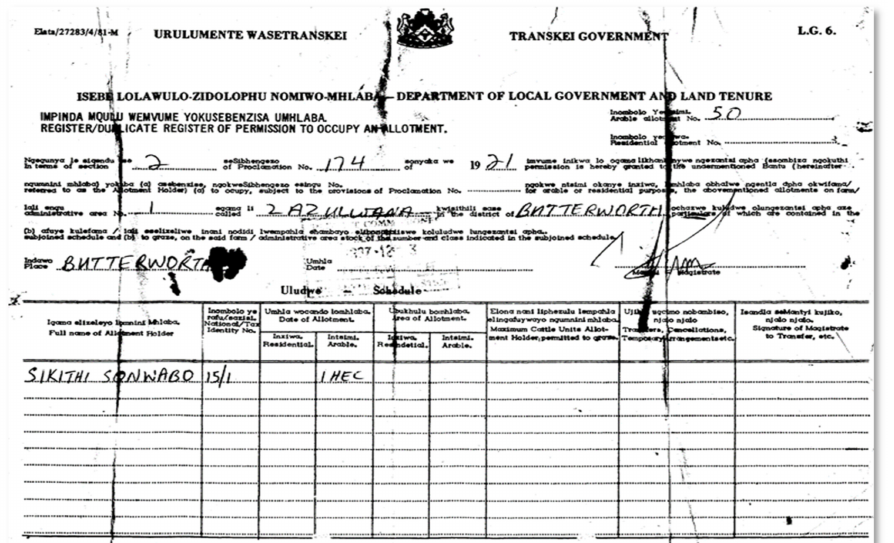
Figure 4. A duplicate copy of a Permission to Occupy (PTO) obtained from the owner, Mr Sonwabo Sikithi, on the 26 October 2020. His PTO of 1 hectare is situated in the Administrative area of Zazulwana, District of Butterworth, Eastern Cape Province.